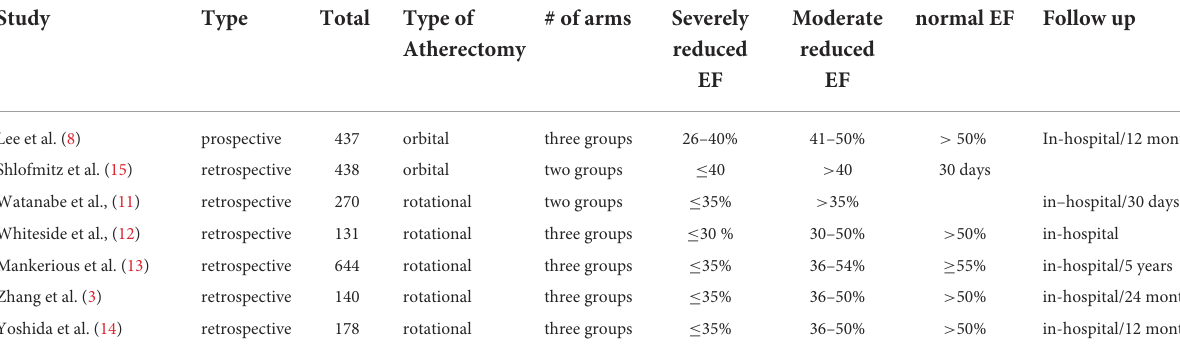
TABLE 1 Study characteristics included in the